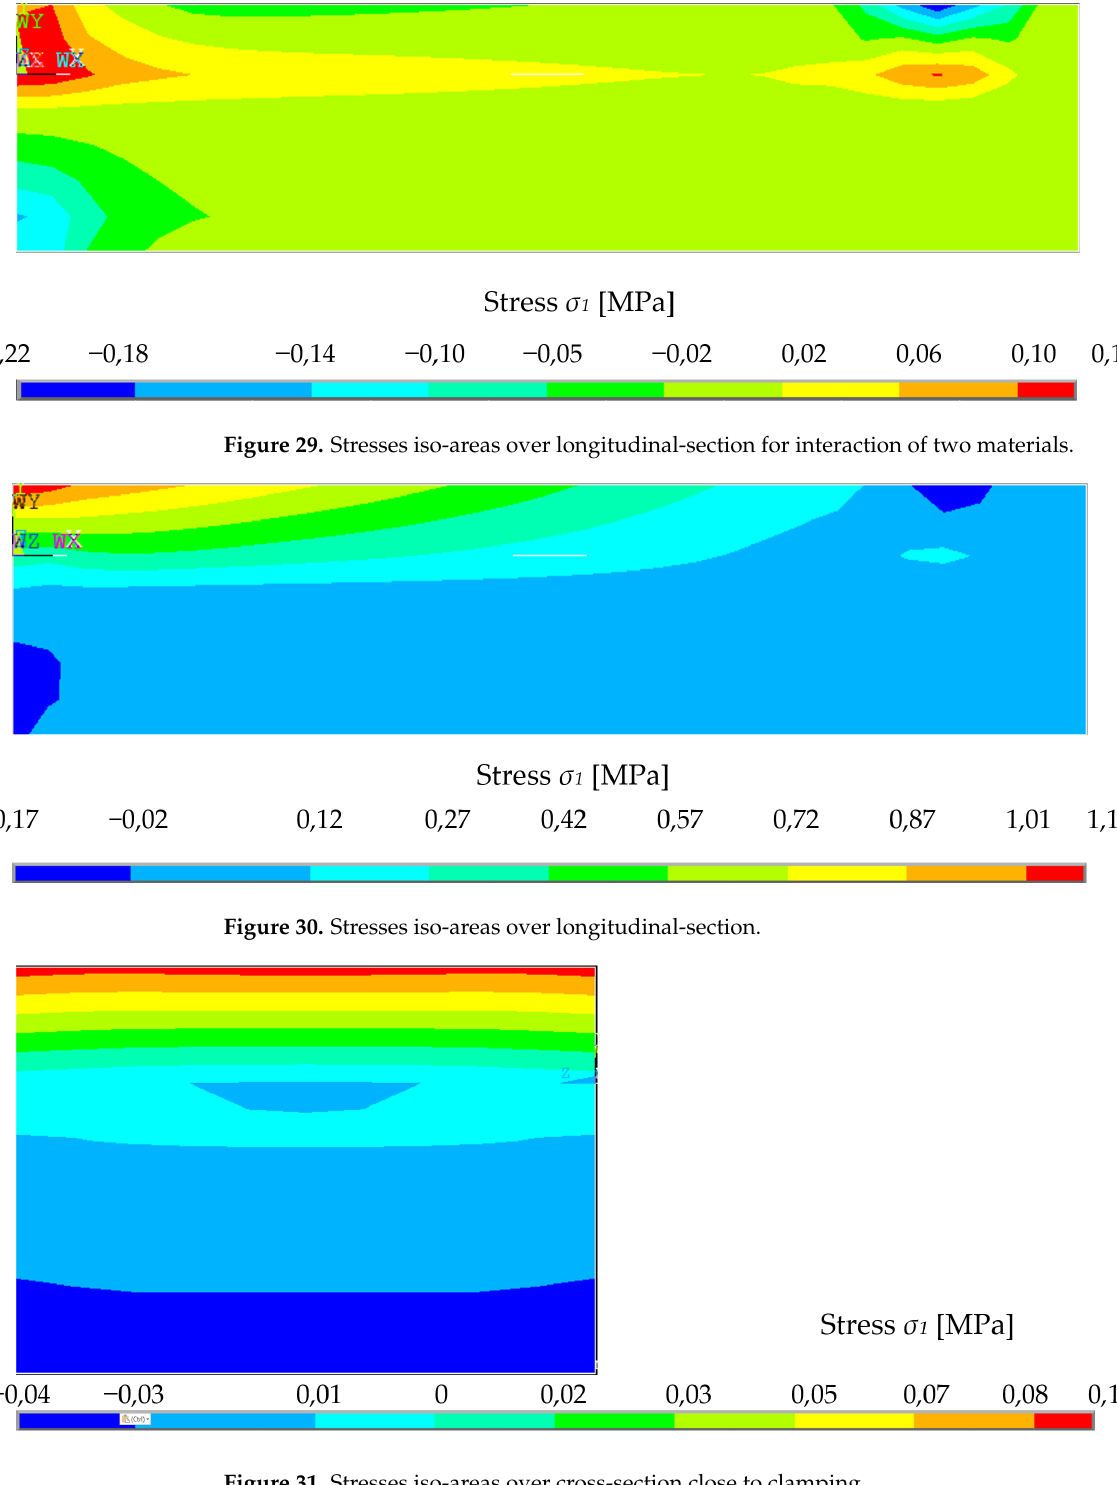
Figure 31. Stresses iso-areas over cross-section close to clamping.